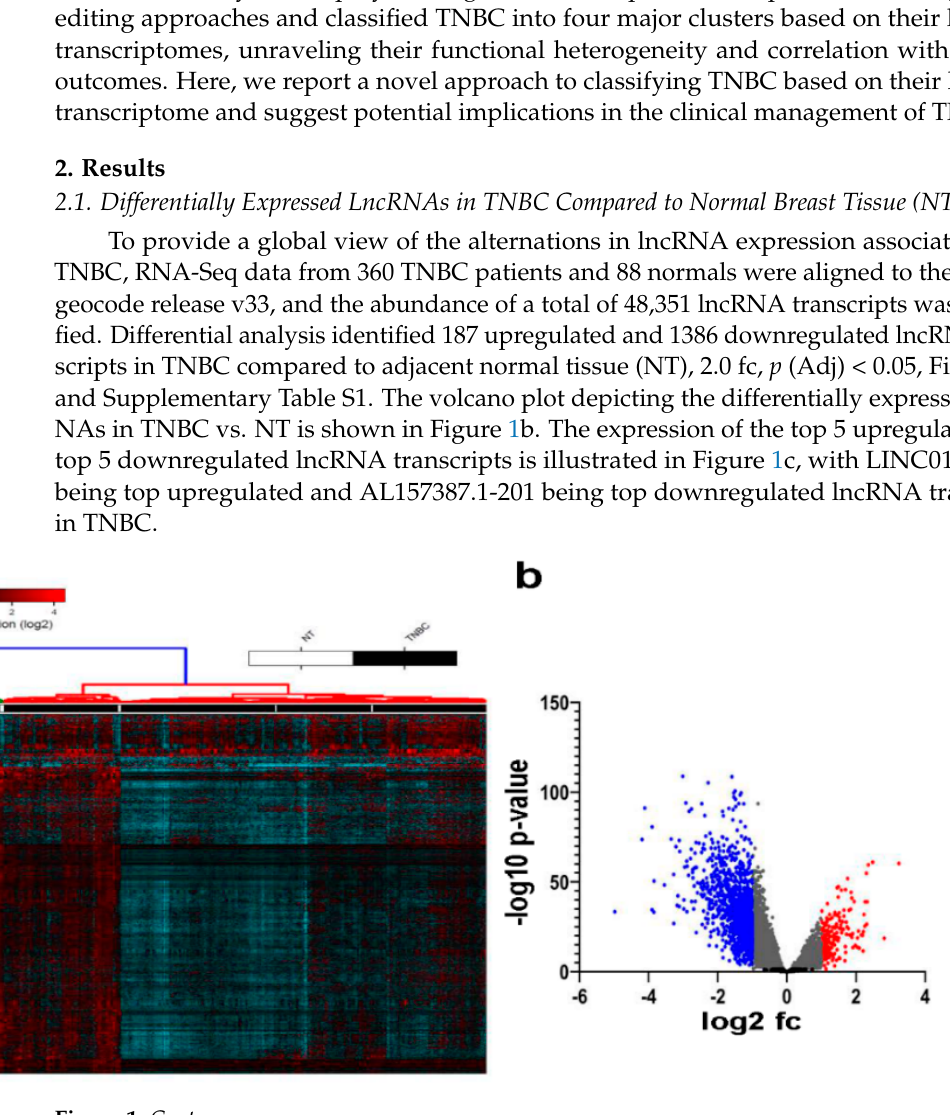
Figure 1. Differentially expressed lncRNAs in TNBC compared to normal breast tissue (NT). RNA − Seq data were aligned to the human geocode release v33, and the abundance of each lncRNA transcript was quantified. ( a ) Hierarchical clustering of TNBC (n = 360) compared to NT (n = 88). Each column represents one sample, and each row represents the lncRNA transcript. The expression level of each transcript (log2) is depicted according to the color scale. ( b ) Volcano plot depicting upregulated (red) and downregulated (blue) lncRNAs in TNBC compared to NT. ( c ) Scatter plot depicting the expression of the top 5 upregulated (upper panel) and downregulated (lower panel) lncRNA transcripts in TNBC compared to NT. **** p < 0.00001. 2.2. Molecular Heterogeneity of TNBC Employing the LncRNA Transcriptome We subsequently sought to classify TNBC (TNBC = 360 and normal = 88) based on their lncRNA transcriptome employing the ICGS algorithm. Using this approach, we were able to classify TNBC and NT into four main clusters (C0, C2, C3, and C1), with each cluster having a distinctive lncRNA expression profile (Figure 2a) and Supplementary Ta- ble S2. Based on the enrichment of selected lncRNA transcripts, the four clusters were designated LINC00511-enriched (551-Enr), LINC00393-enriched (393-Enr), FIRRE-en- riched (FIRRE-Enr), and normal tissue-like (NT-like), respectively. The NT-like cluster clustered with the NT. A similar pattern was also seen when utilizing the UMAP dimen- sionality reduction analysis (Figure 2b). Expression of the top 5 lncRNA transcripts in each cluster (C0, C2, C3, and C1) in the same cohort is shown in Figure 2c.